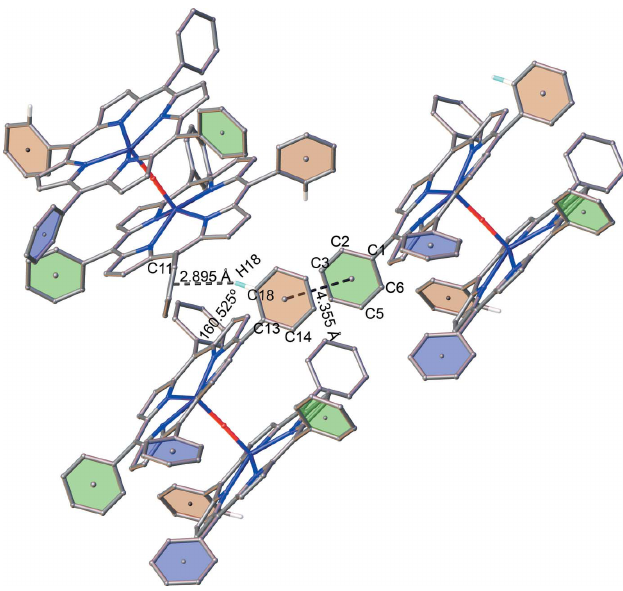
Figure 4 Relevant intermolecular C—H (cid:4)(cid:4)(cid:4) (cid:2) and (cid:2) – (cid:2) interactions in the crystal structure of the title